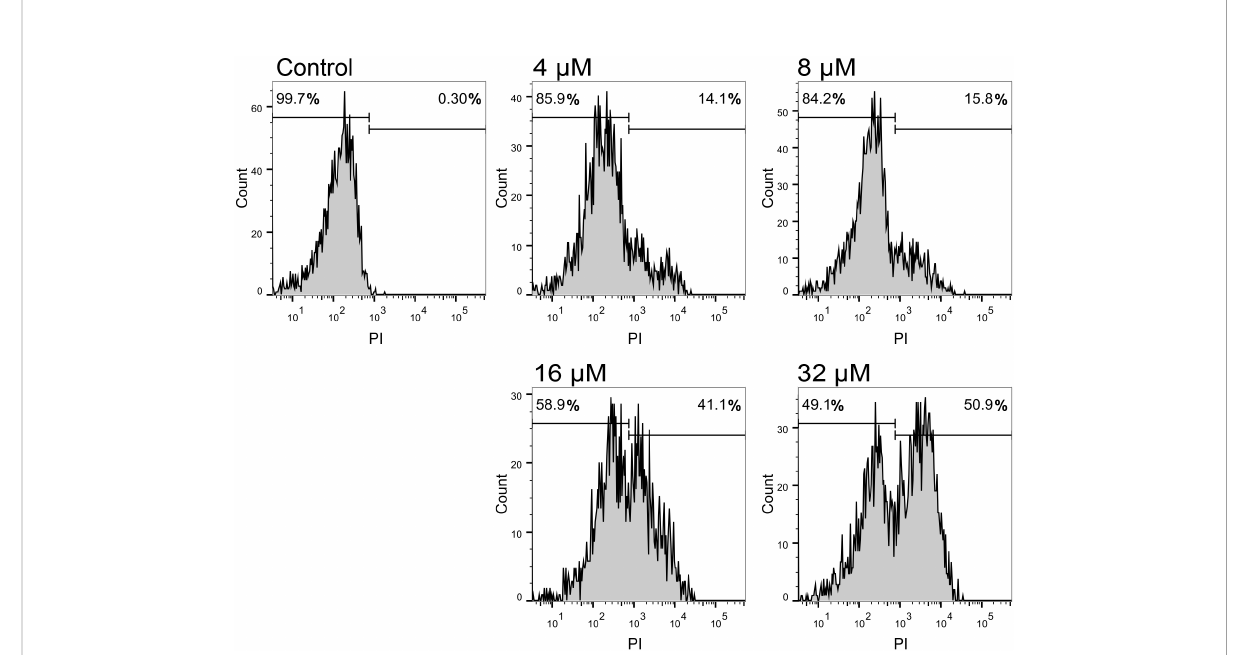
FIGURE 7 Flow cytometric analysis of P. plecoglossicida treated with SKL17-2 at different doses. P. plecoglossicida were incubated with SKL17-2 for 2 h at 28°C. The in fl ux of PI into bacterial cells was then examined using fl ow cytometry. The cell-penetrating ef fi ciency was shown as percentage. Data are representative of three independent experiments.